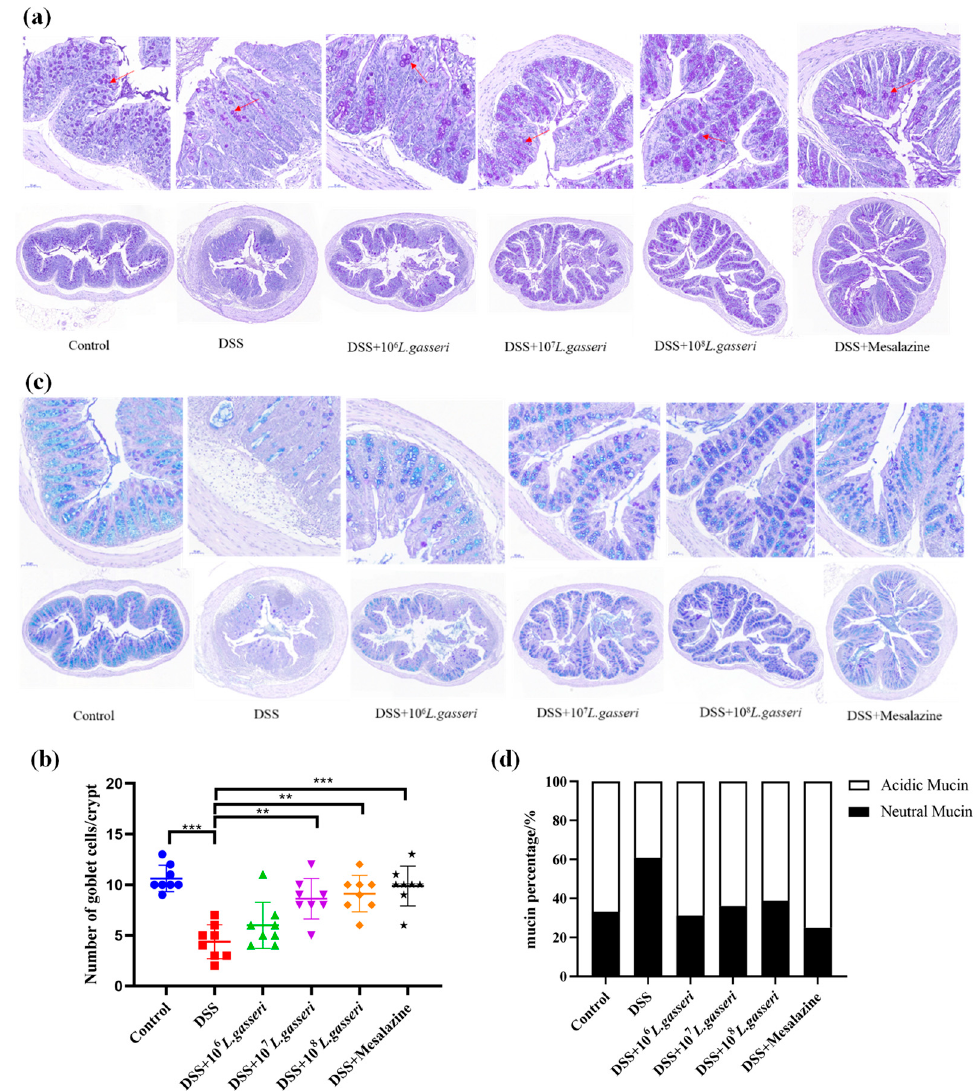
Figure 6. Staining and distribution of goblet cells and mucin. ( a ) Staining of goblet cells in colonic tissue, ( b ) counting of goblet cells in colonic tissue, ( c ) staining of mucin and distribution in colonic tissue, and ( d ) distribution of mucin in colonic tissue. ** p < 0.01, *** p < 0.001 represent significant difference between groups.